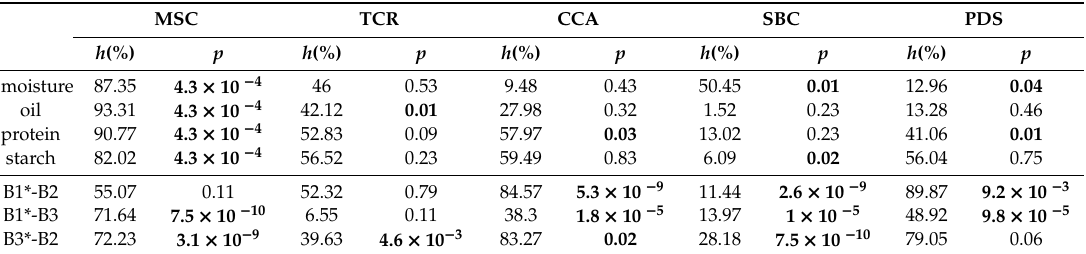
Table 4. RMSEP comparison of CTAI and other methods, RMSEP improvements and p values by the Wilcoxon signed rank test ( α = 0.05). The m5spec was used as the master spectra, and the mp6spec was used as the secondary spectra for corn dataset. The protein content was chosen as the property for wheat dataset.